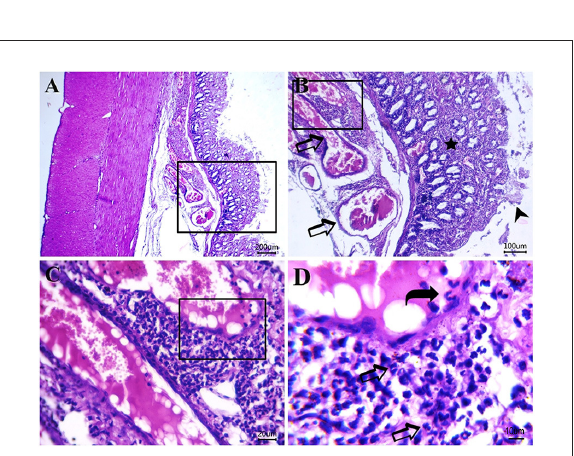
FIGURE8 Photomicrograph of H&E-stained sections from cat idiopathic megacolon that had ≥ 6 months duration of constipation/obstipation showing moderate to severe degenerative changes: (A, B) Catarrhal lesions in the colonic epithelium [desquamated colonic epithelium (arrowhead), inflammatory cells infiltrate (star) between degenerated and necrotized colonic glands and congested blood vessels (arrow)]. (C, D) Submucosal neutrophils infiltrations (arrows) and clearly visible adhered neutrophils to blood vessel endothelium (curved arrow) for the transmigration process. Scale bar 200, 100, 20, and 10 µ m, respectively.